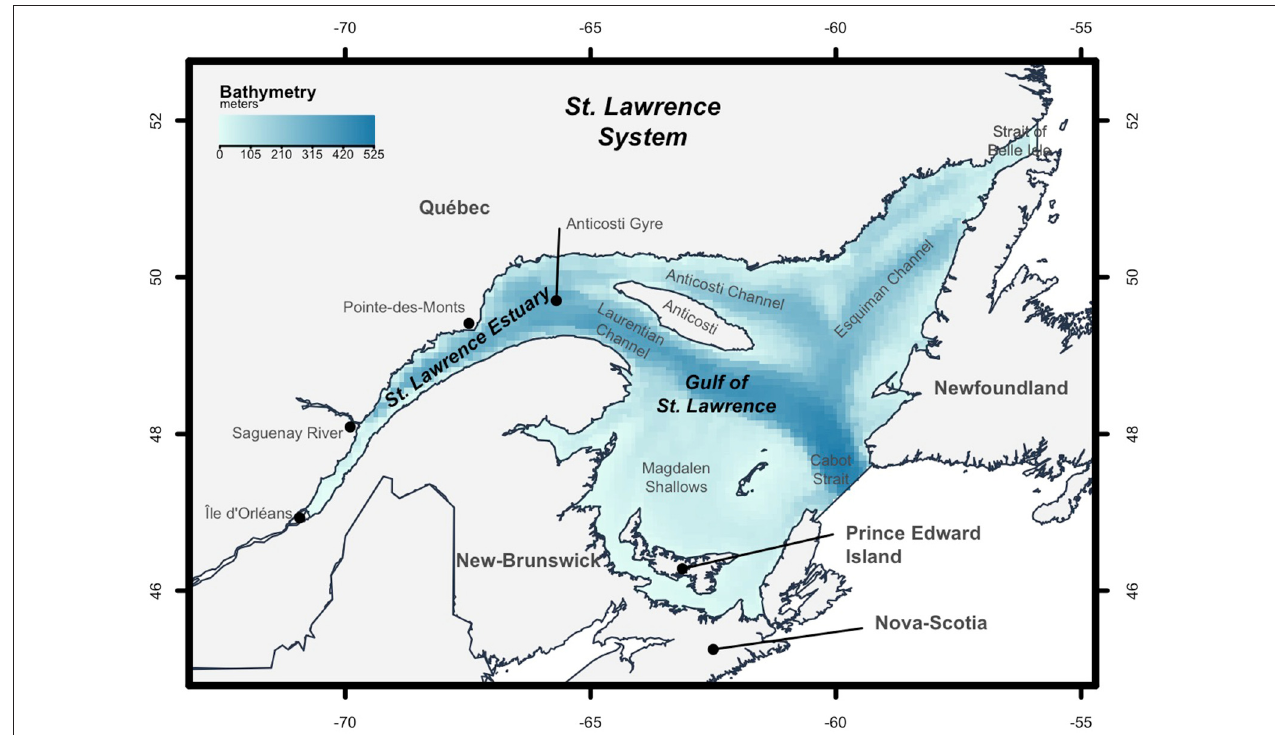
FIGURE 1 | Description of the St. Lawrence System in Eastern Canada, composed of the St. Lawrence Estuary and the Gulf of St. Lawrence. The Estuary is defined by the limit of seawater intrusion, close to Île d’Orléans, to the west and by its connection to the Gulf near Pointe-des-Monts. The Gulf is an interior sea connected to the Atlantic by Cabot Strait and the Strait of Belle Isle to the south and north of Newfoundland, respectively.